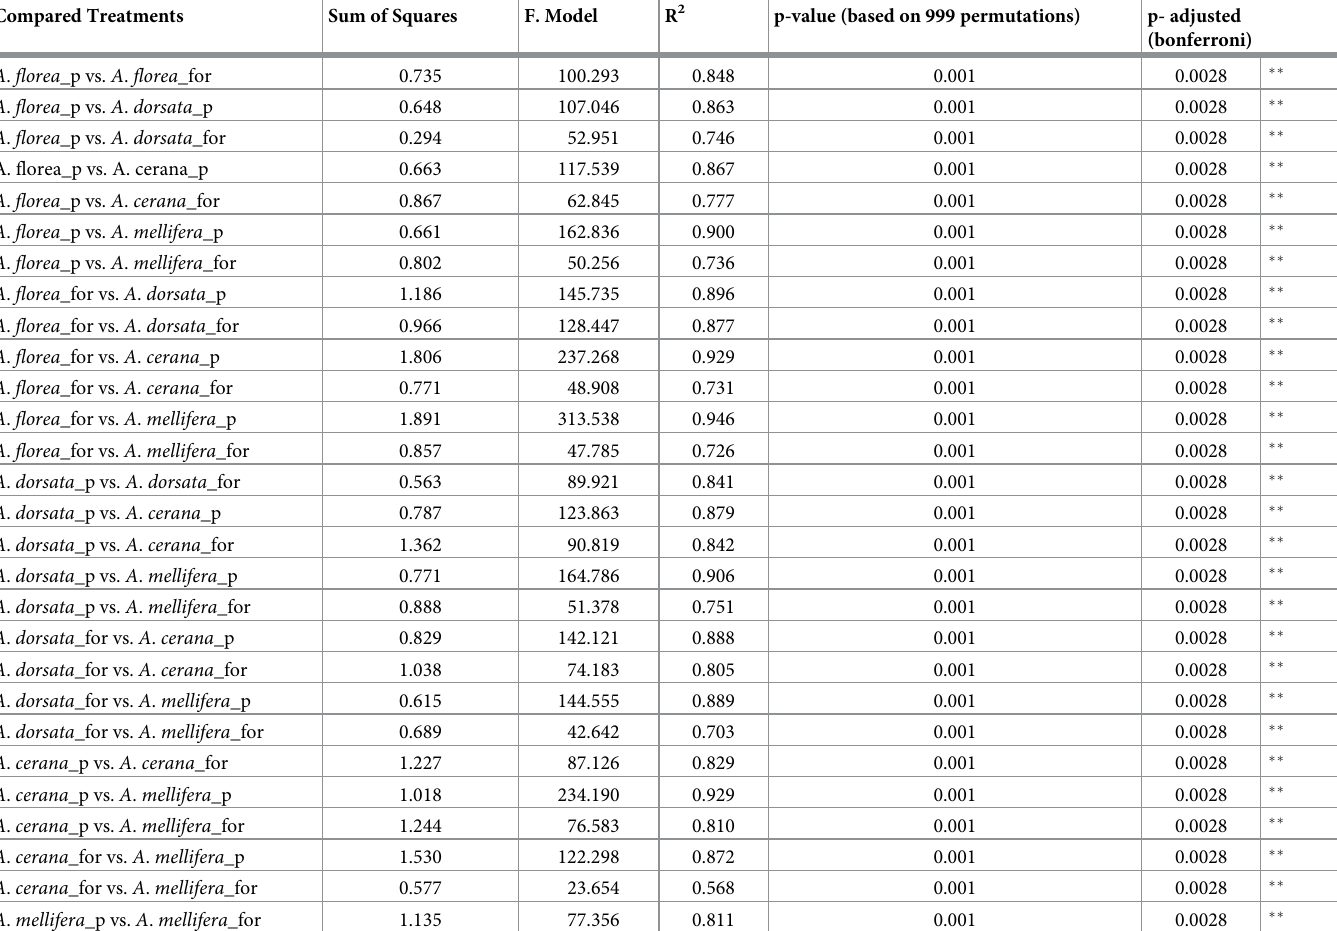
Table 3. Pairwise permutational multivariate analysis of variance using distance matrices to reveal differences in the CHC profile composition between the species- developmental stage interactions. Compared